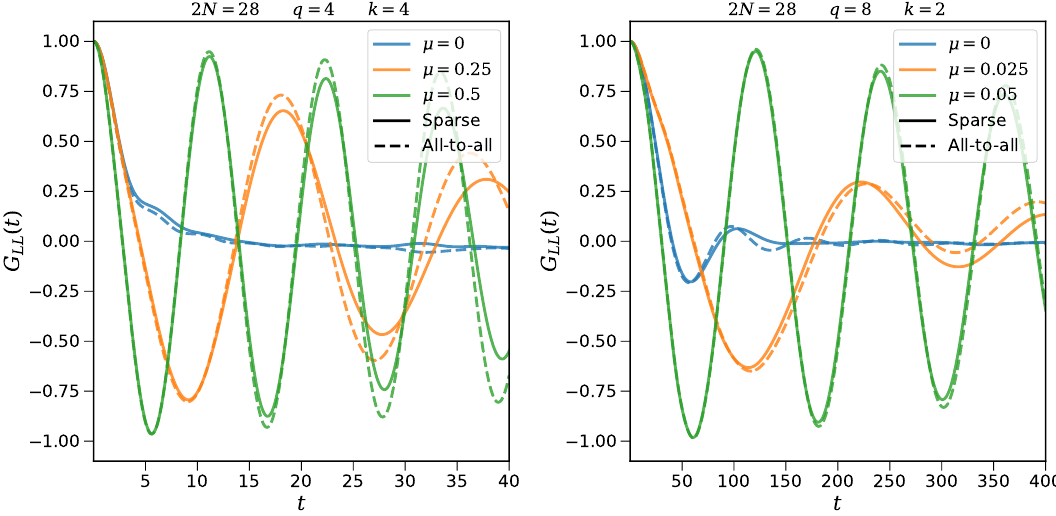
Figure 5. Retarded Green’s function G LL for the two coupled sparse SYK model (solid) compared to the corresponding all-to-all SYK (dashed) for 2 N = 28 for different values of the coupling µ . We set q = 4 , k = 4 (left) and q = 8 , k = 2 (right), and each curve is obtained from an average over 100 realizations of the random